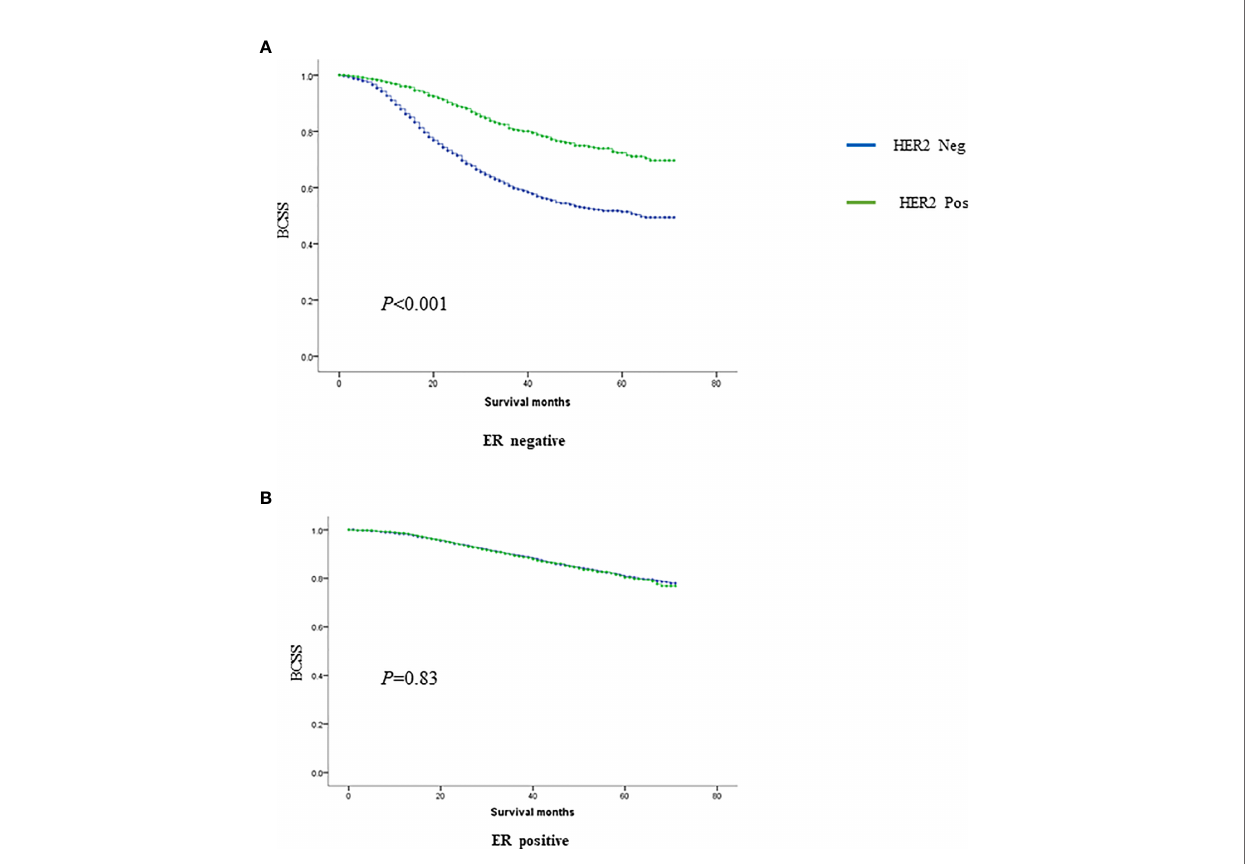
FIGURE 2 | The prognostic value of HER2 in ER negative (A) and positive (B) tumors.